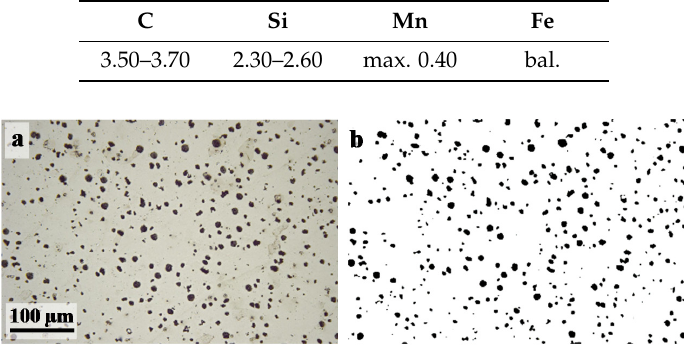
Table 1. Chemical composition of the EN-GJS-500-7 cast iron in %.